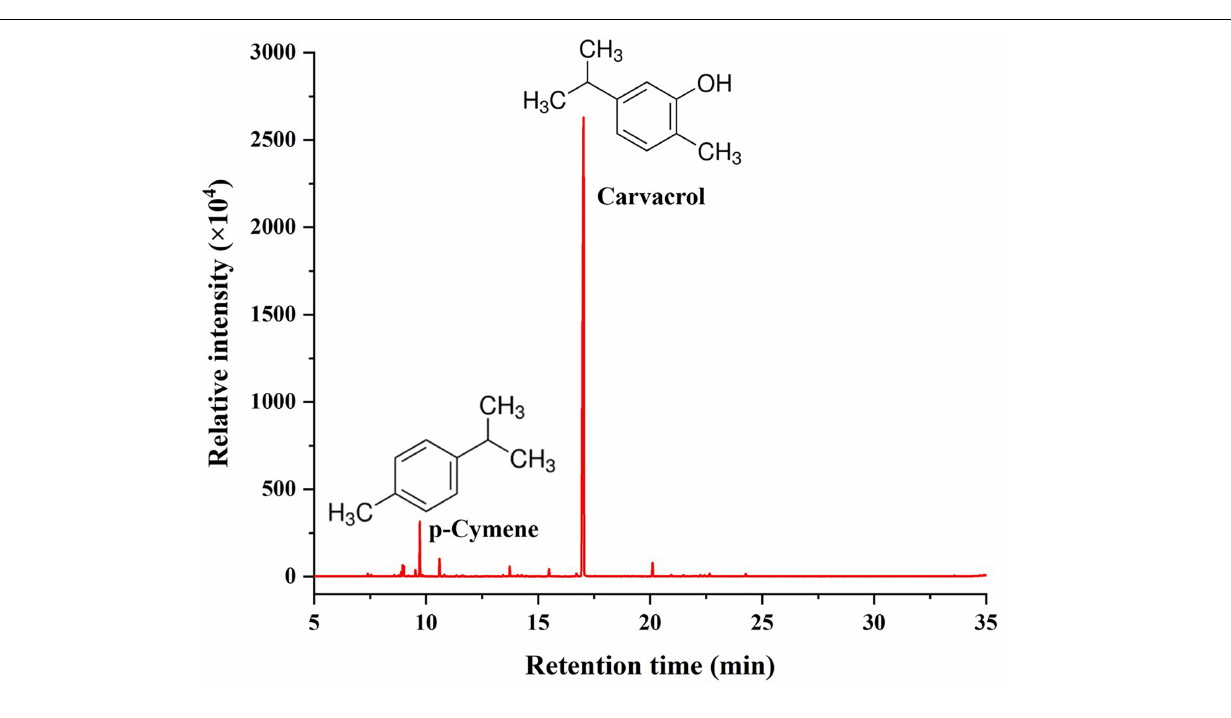
FIGURE 1 | Chemical composition of